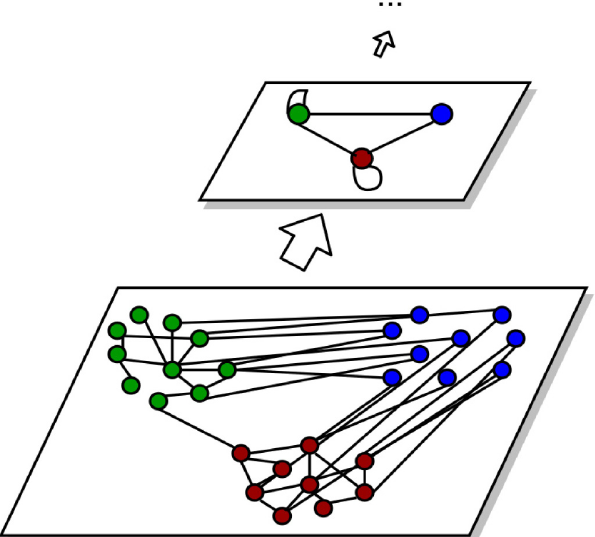
Fig 3. The resulting SBM of a graph can be represented as a multi-graph, which contains a node for each block and the edges between the blocks like in the underlying graph. Based on this representation of a SBM the process of inference can be iterated by applying the method again to this